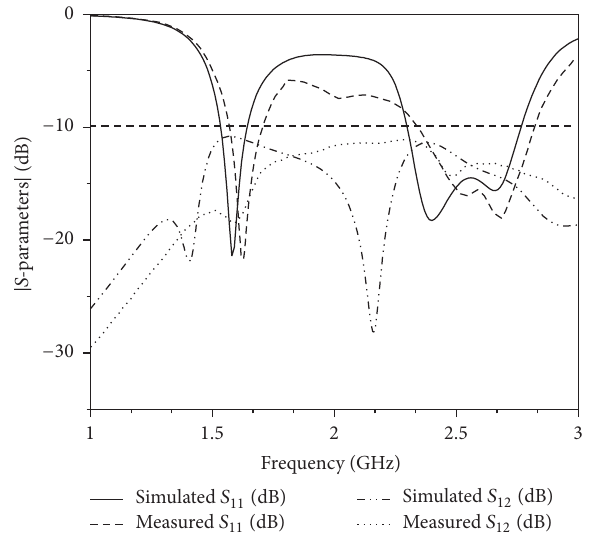
Figure 12: The simulated and measured 𝑆 -parameters (dB) for the second configuration (PIN diodes switched ON).